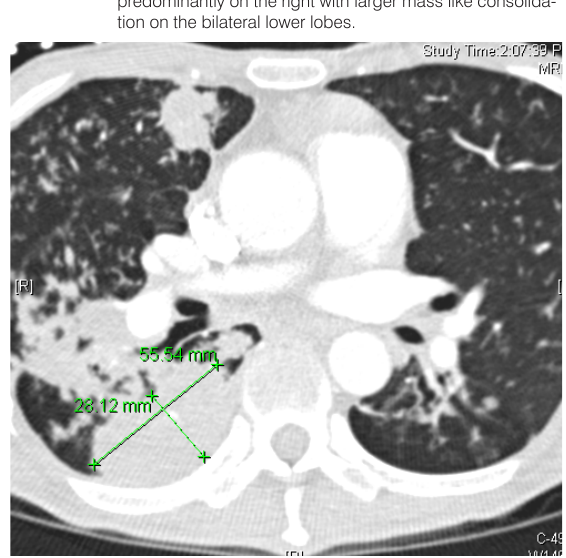
Figure 1. CT chest with multiple pulmonary nodules in both lungs, predominantly on the right with larger mass like consolida- tion on the bilateral lower lobes.